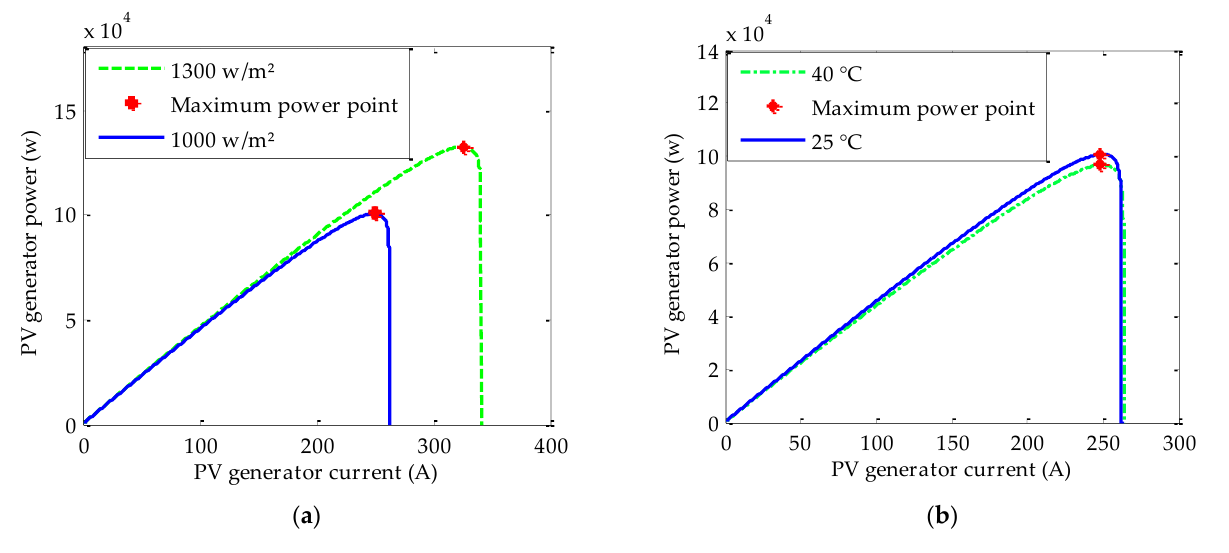
P f V = () Figure 3. PV generator P pv = f ( V pv ) characteristic: ( a ) under radiation variation and ( b ) under Figure 3. PV generator characteristic: ( a ) under radiation variation and ( b ) under p v p v temperature temperature variation.